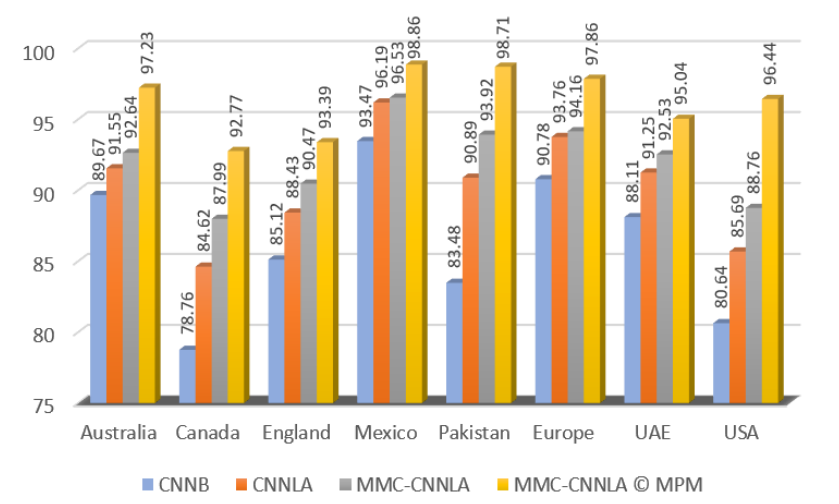
Figure 16. Graphical representation of integrated modules overall performance with base structure.